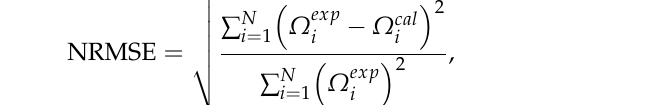
Figure 14. Scatter plot between experimental and calculated values of maximum inundation height.